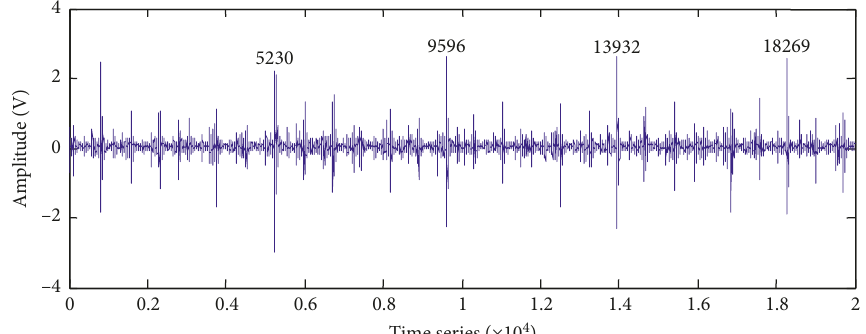
Figure 10: The cylinder head’s vibration signal of diesel engine.